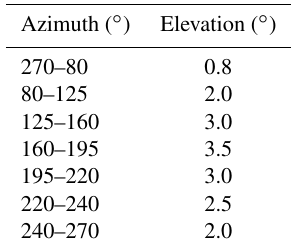
Table A2. Elevation angles as a function of azimuth angle of the operational PCP scan at